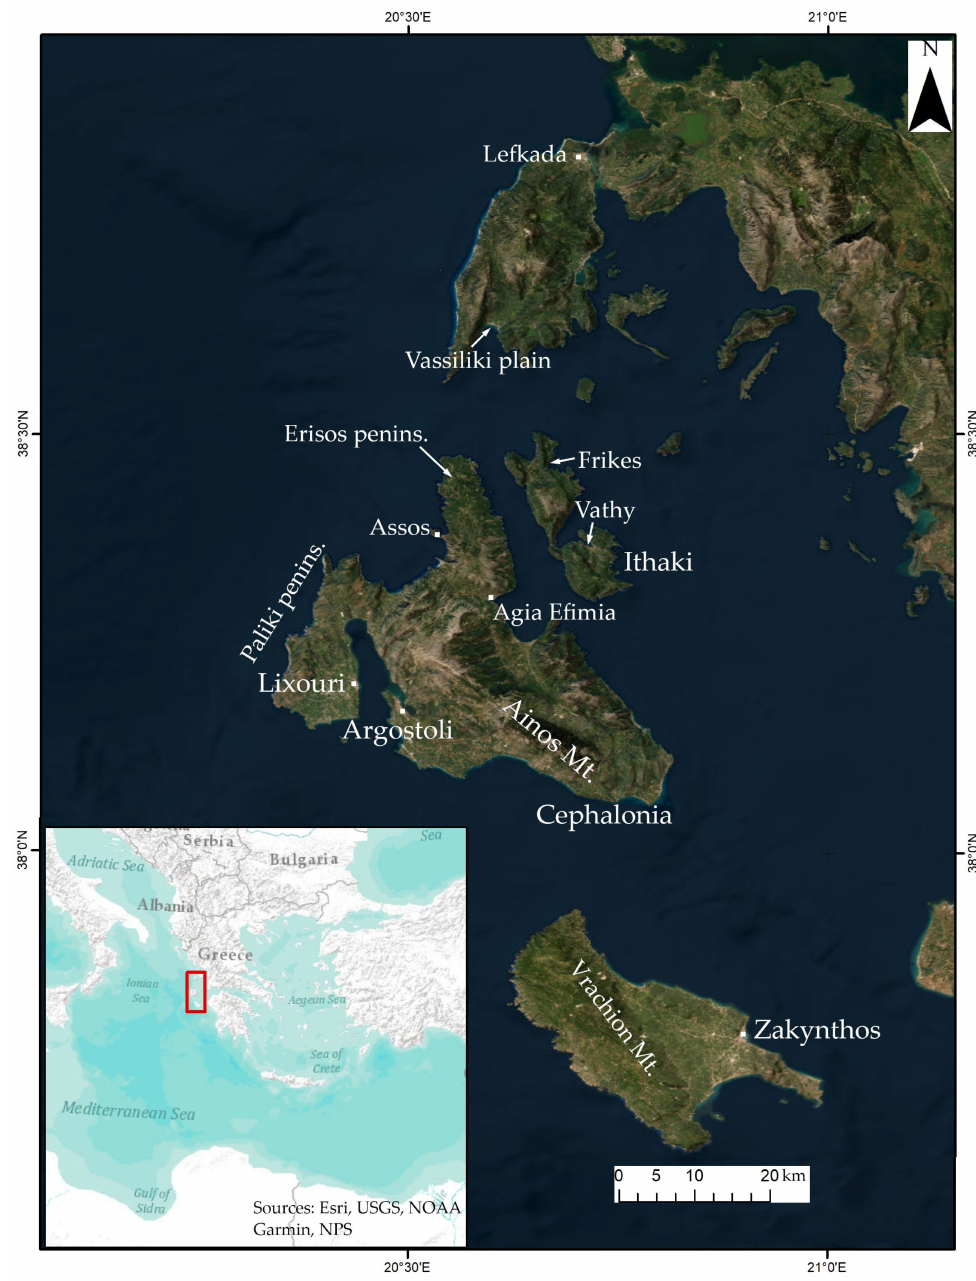
Figure 1. Location map of the study area, showing the central and south Ionian Islands (Lefkada, Ithaki, Cephalonia, and Zakynthos), along with certain important locations. Map source: ESRI, Maxar, GeoEye, Earthstar